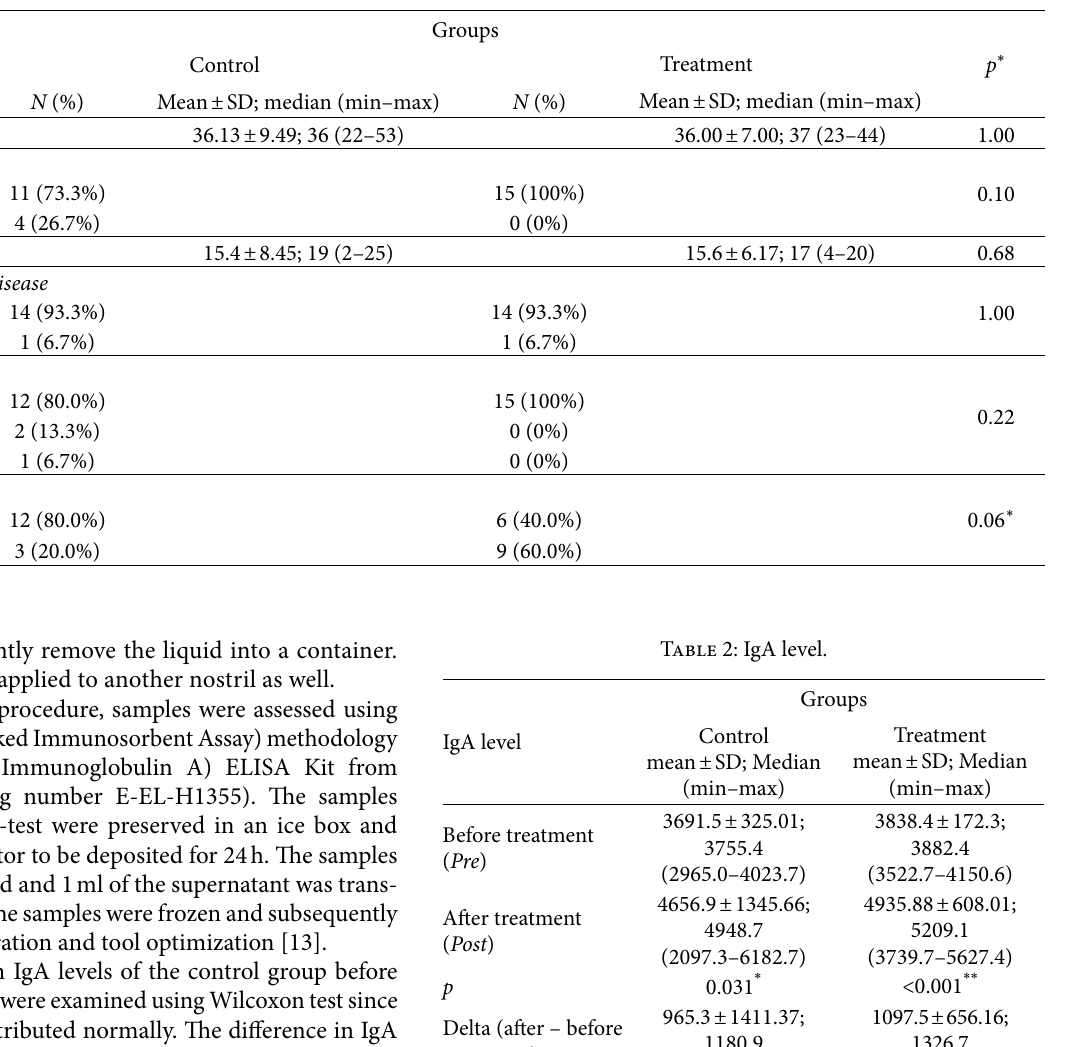
Table 1: Characteristics of the subject ( N =30).